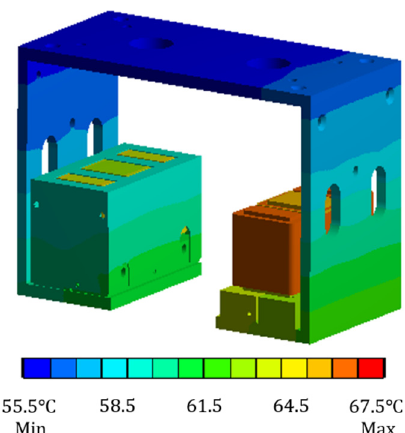
Figure 10. Cloud diagram of steady-state temperature field distribution of electromagnet with suspension support when only copper loss is considered.